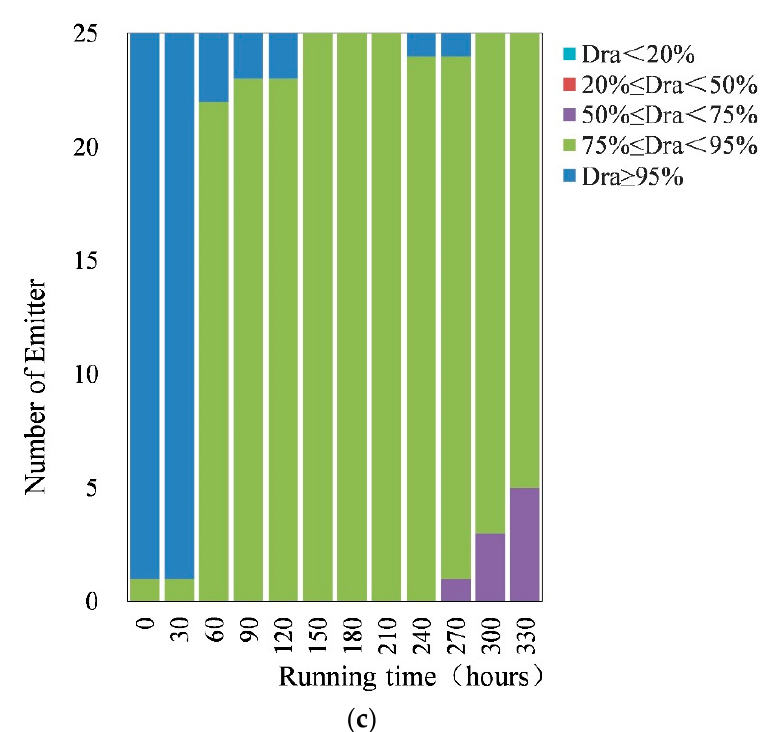
Figure 3. Bar chart of the number of emitters with different clogging degrees varies with irrigation time. ( a ) UAI; ( b ) VAI; ( c ) MAI.